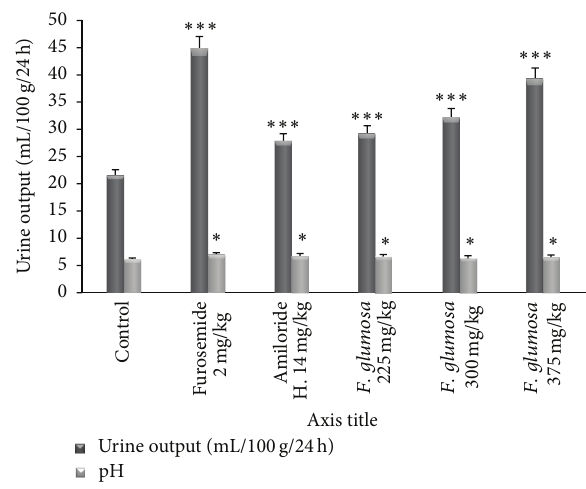
Figure 3: Effects of the aqueous extract of F. glumosa on the urine output and pH. Values are means ± SEM, 𝑛 = 5 , ∗ < 0.05 , ∗ ∗ ∗ < 0.001 , significant difference compared to the